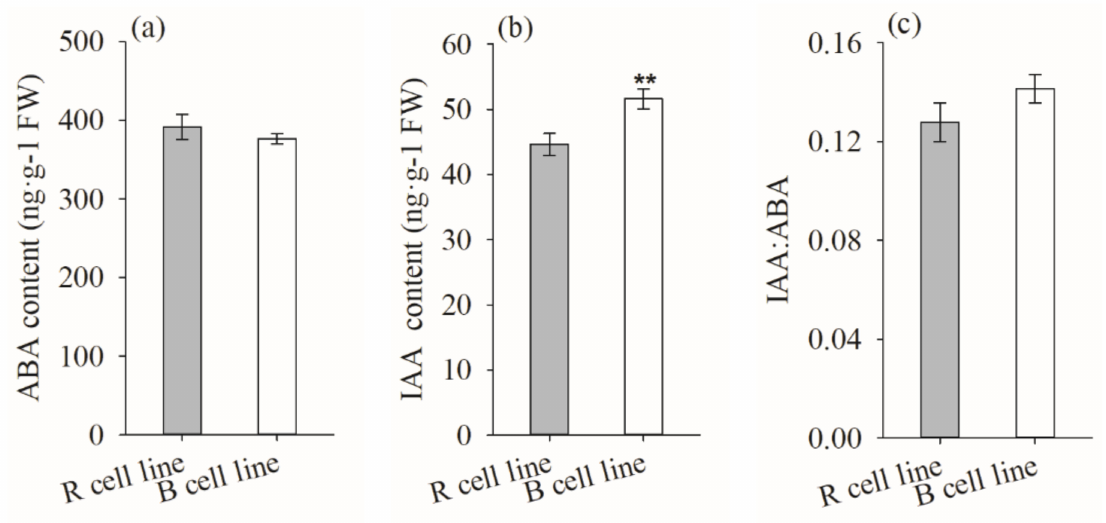
Figure 10. Differences in IAA and ABA contents and the IAA: ABA ratio between P. koraiensis R and B cell lines. ** above the column indicates that the difference is significant at the p < 0.01 level. The highest values were obtained from the 1-1, 1-19, and 8-25 cell lines (mean = 66.75 ng · g − 1 , 543.69 ng · g − 1 , and 0.22, respectively; Figure 11). In addition, it was also found that the IAA content was negatively correlated with cotyledonary SE yield (R = − 0.256, p = 0.007), while the IAA: ABA ratio was positively correlated with cotyledonary SE yield (R = 0.198, p = 0.038; Figure 5).